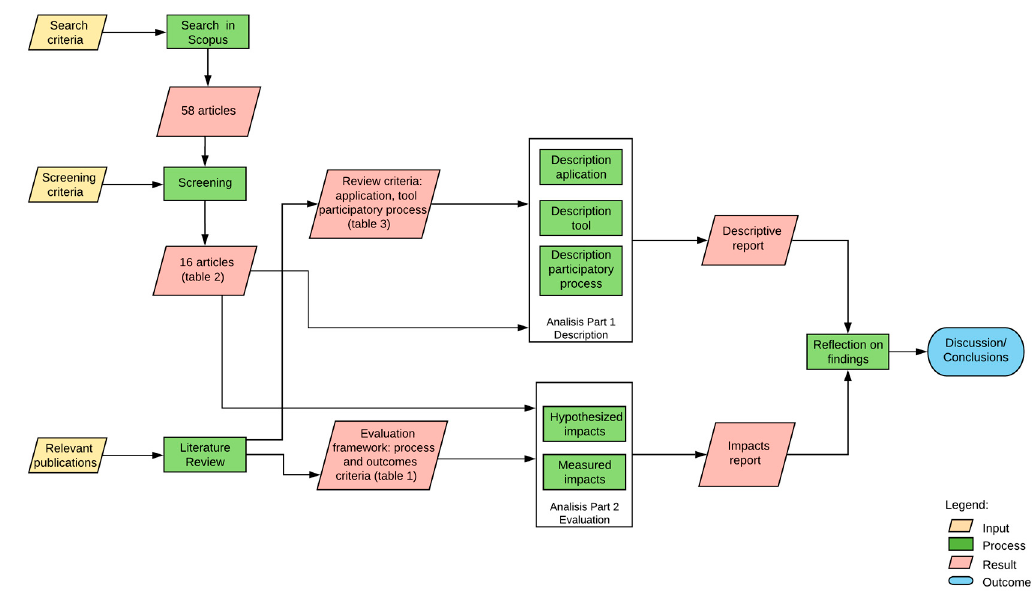
Figure 2. Review Figure 2. Review methodology.